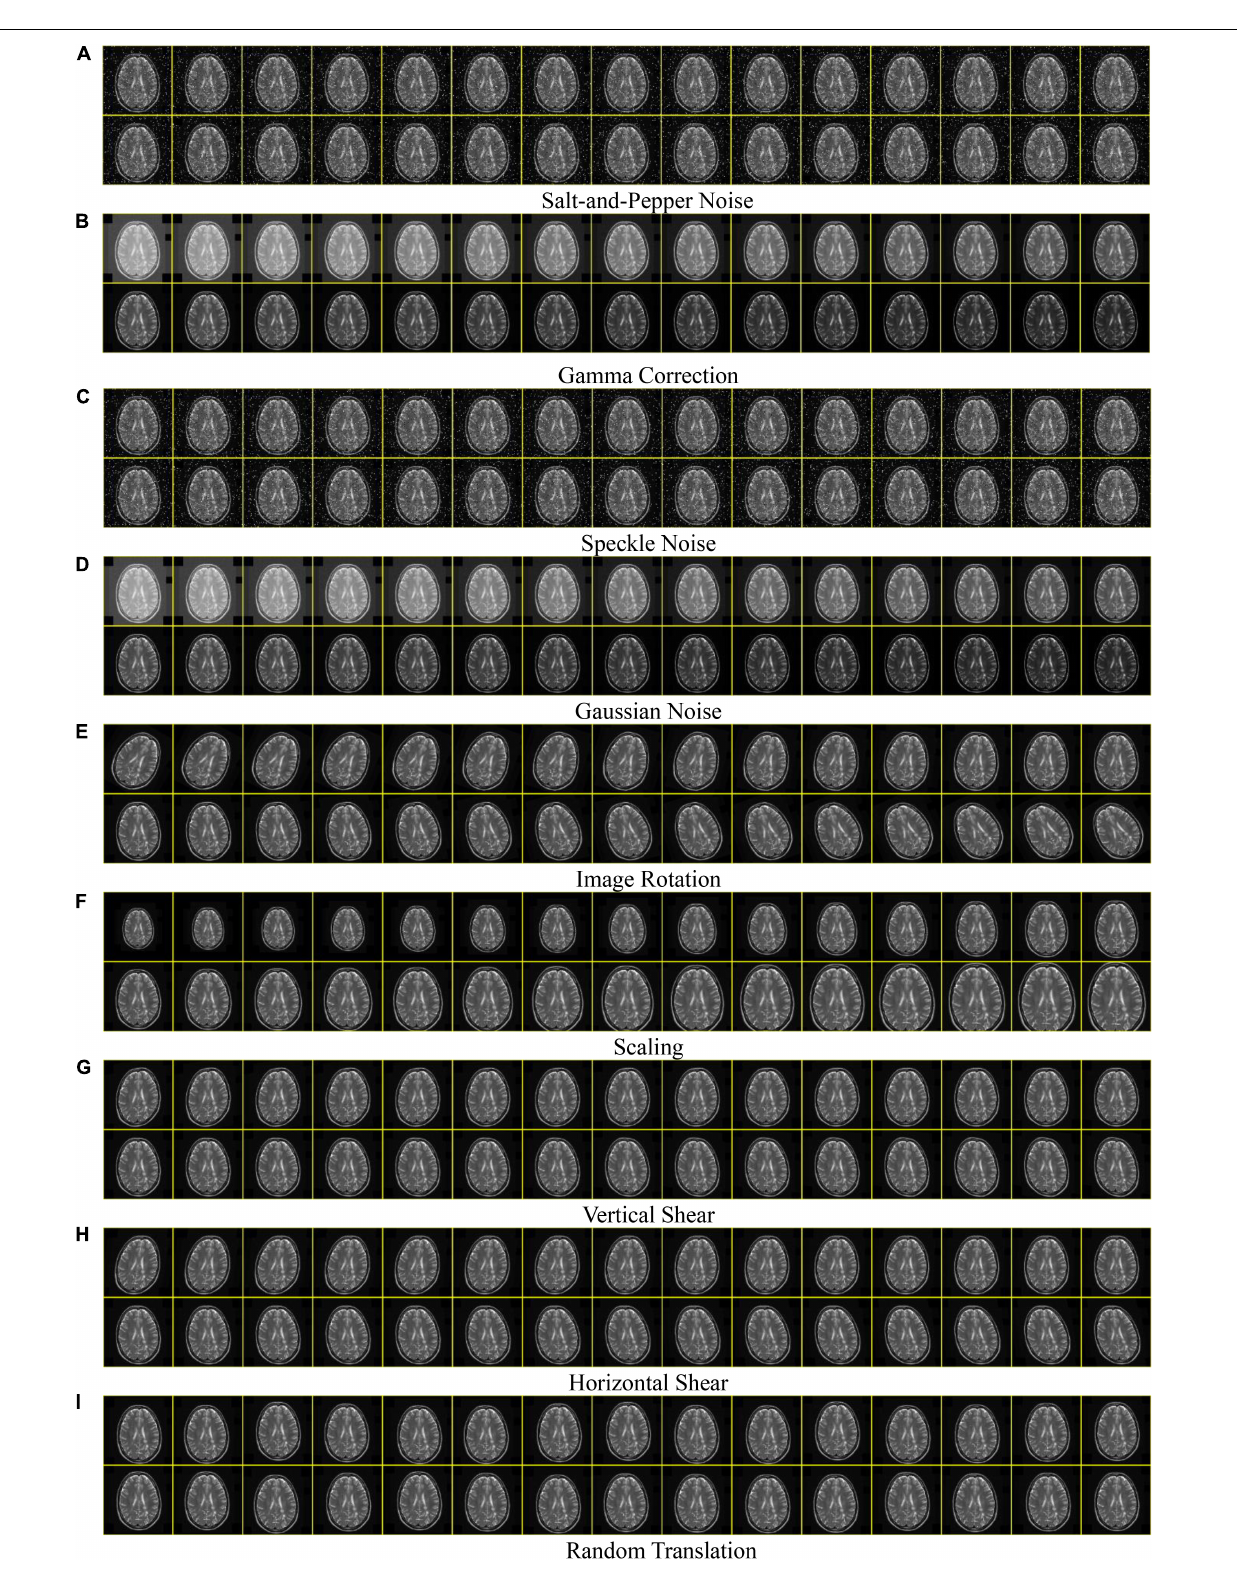
Frontiers in Neuroscience |